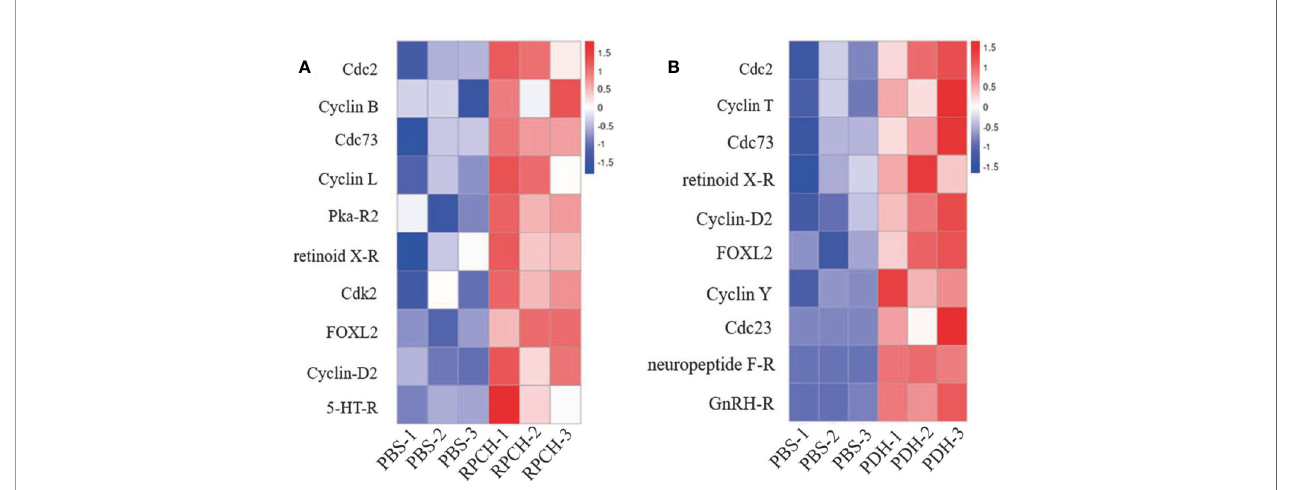
FIGURE 8 | Heat maps of the DEGs related to oocyte meiosis and maturation. (A) The DEGs relative expression levels between the Es-RPCH administrated and PBS control groups ( n = 3 ). (B) The DEGs relative expression levels between the Es- b - PDH administrated and PBS control groups ( n = 3 ). The color re fl ects relative expression levels from high (red) to low